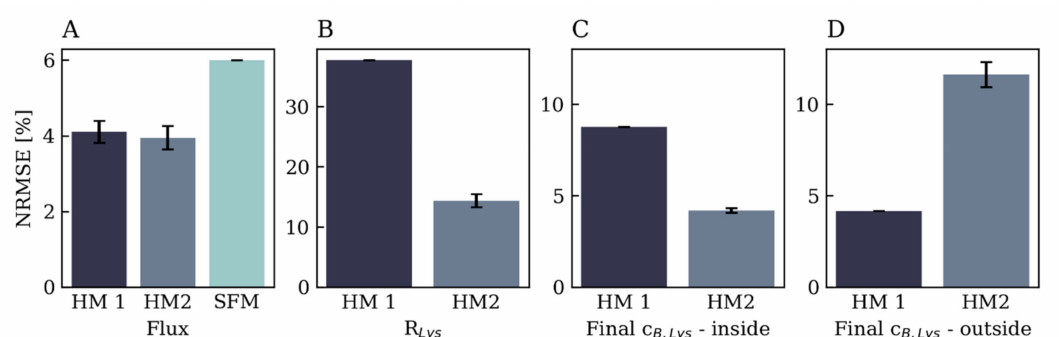
Figure 8. Summary of the prediction errors of HM 1, HM 2 and SFM in terms of ( A ) flux, ( B ) R Lys , ( C ) final c B,Lys for test runs 1 to 4 with all parameters—TMP, CF, initial c B,BSA and c B,Lys —inside the training space and ( D ) final c B,Lys for test runs 5 to 8 performed partly outside the training